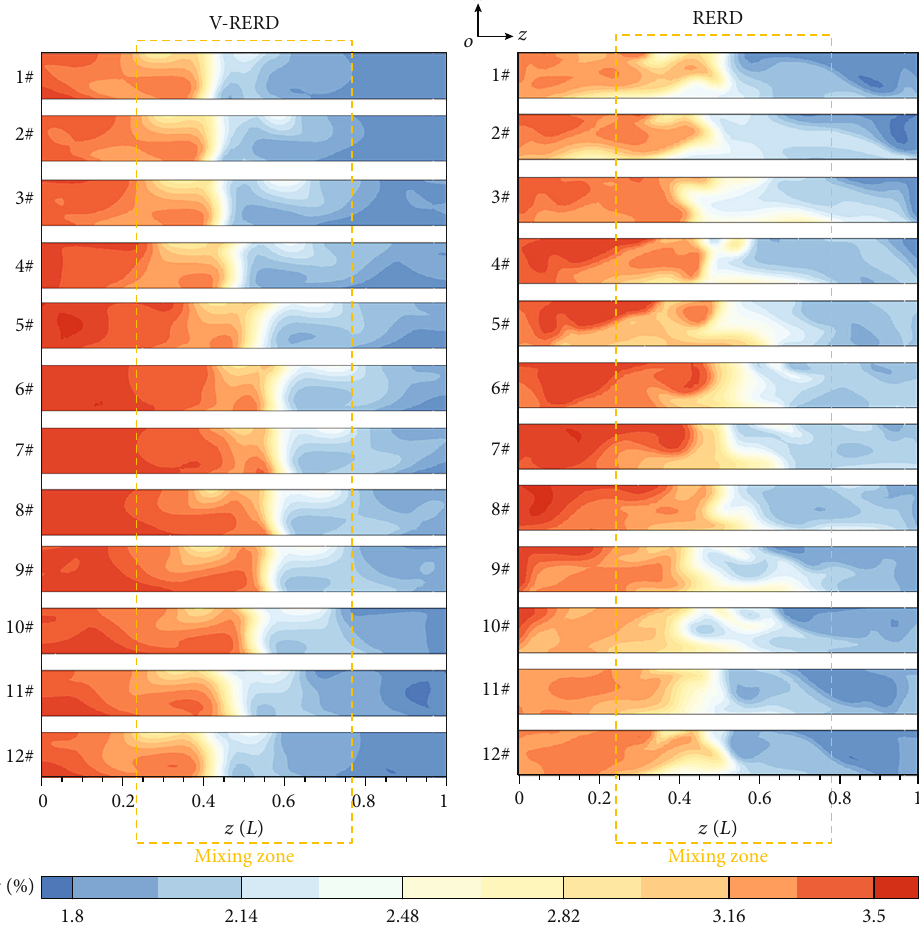
Figure 13: Salinity distributions in V-RERD and